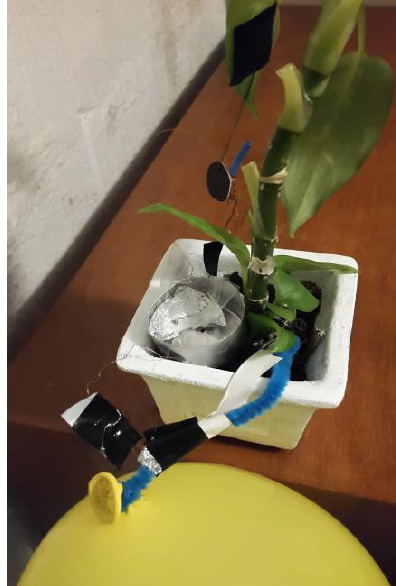
Figure 2. Dieffenbachia seguine, in pot with soil, electrodes, inductor coil behind a magnet (black), capacitor on the blue string and Sun Catcher Cup. When the balloon moves, the capacitor becomes active creating AC. The Cup collect extra energy from light and heat, if any. This pottery arrangement shows that a plant with access to electromagnetic energy (plausibly able to release beneficially,) can adjust and grow in a dark